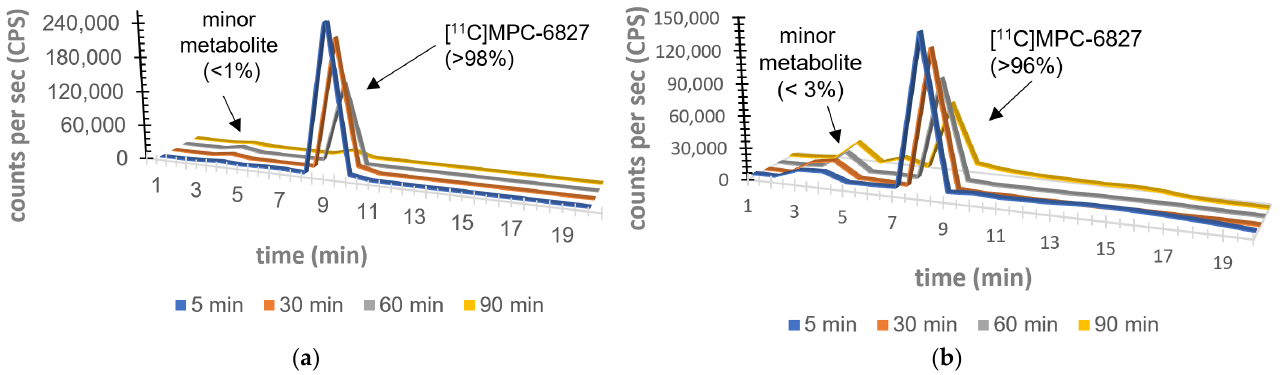
Figure 4. Metabolic assay of [ 11 C]MPC-6827 in rat ( a ) plasma; ( b ) brain sample. ( n = 4/time-point).